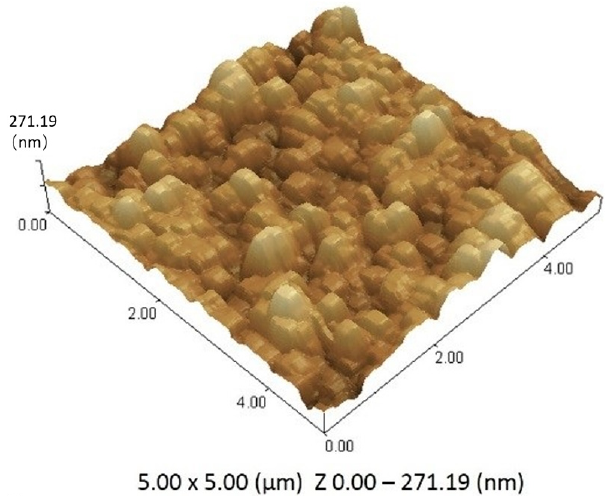
Figure 4. Scanning electron microscopy photographs of ( A ) EBT and ( B ) ETF-5 film.